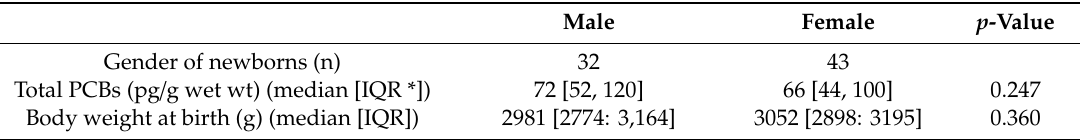
Table 1. Characteristics of newborn at Onodera Ladies Clinic (n = 75; data for gender, PCBs, methylation array data, and birth weight were available).